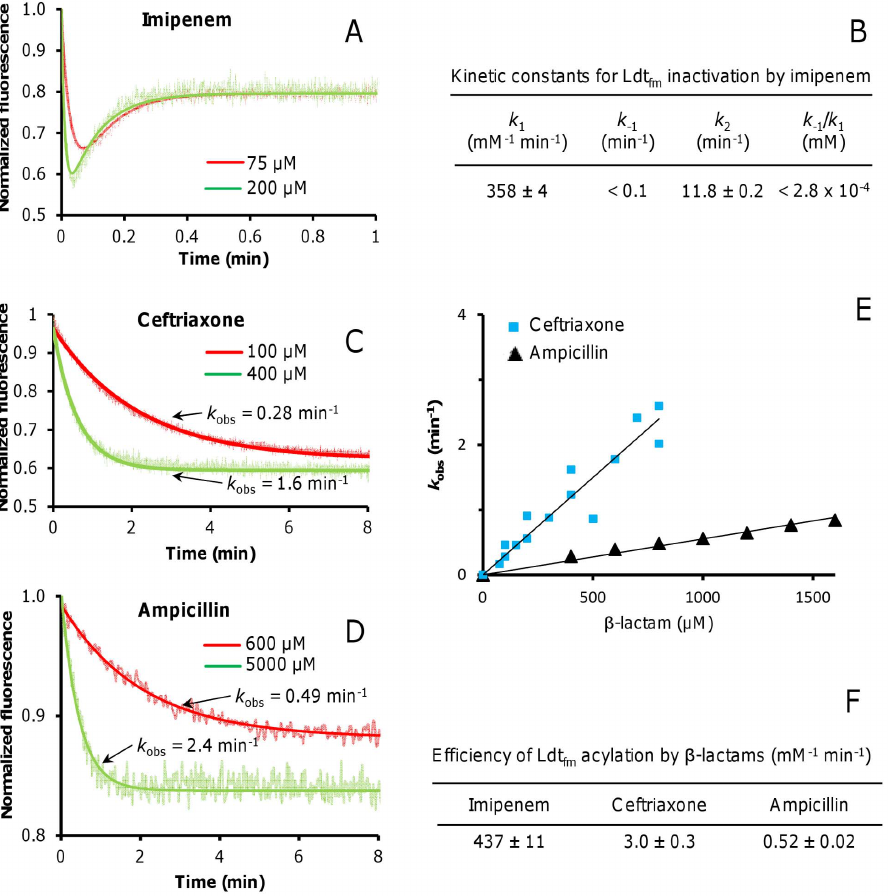
Figure 6. Kinetics of Ldt fm inactivation by imipenem, ceftriaxone, and ampicillin. Fluorescence kinetic data were acquired with a stopped- flow apparatus. Trp residues of Ldt fm were excited at 224 nm and fluorescence emission was determined at 335 nm to monitor quenching upon b - lactam binding. Kinetics were biphasic for imipenem (A) providing estimates of catalytic constants k 1 , k 2 1 , and k 2 (B). See Supplementary methods in File S1 for the iterative fitting method and Supplementary Fig. S2 in File S1 for the complete set of data. Monophasic fluorescence decreases observed for ceftriaxone (C) and ampicillin (D) were fitted to exponential decays (representative plots are shown). Regression analysis was performed with equation F t =F eq + D F e 2 k obst in which F eq and F t are the fluorescence intensities at equilibrium and at time t, respectively, D F is the difference between fluorescence intensity at time=0 and at equilibrium, t is time, and k obs is a constant. The resulting rate constants ( k obs ) increased linearly with the drug concentration (E) and the slope provided an estimate of the efficiency of enzyme acylation (F).